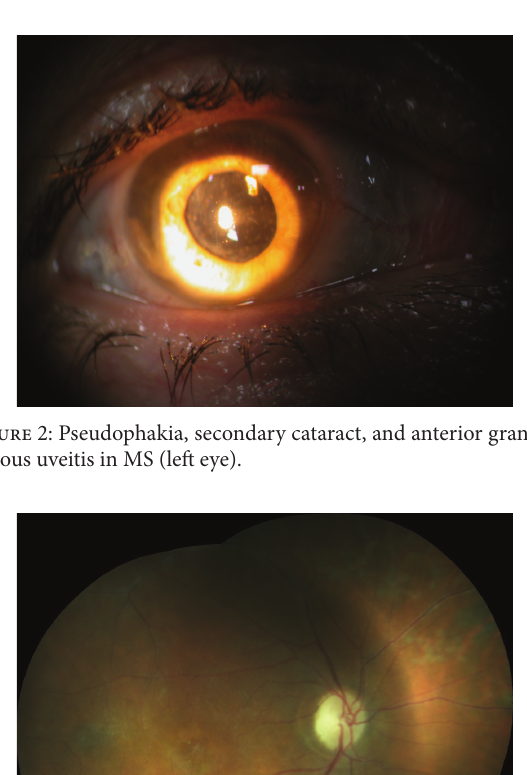
Figure 1: Pseudophakia, secondary cataract, and anterior granulo- matous uveitis in MS (right eye).